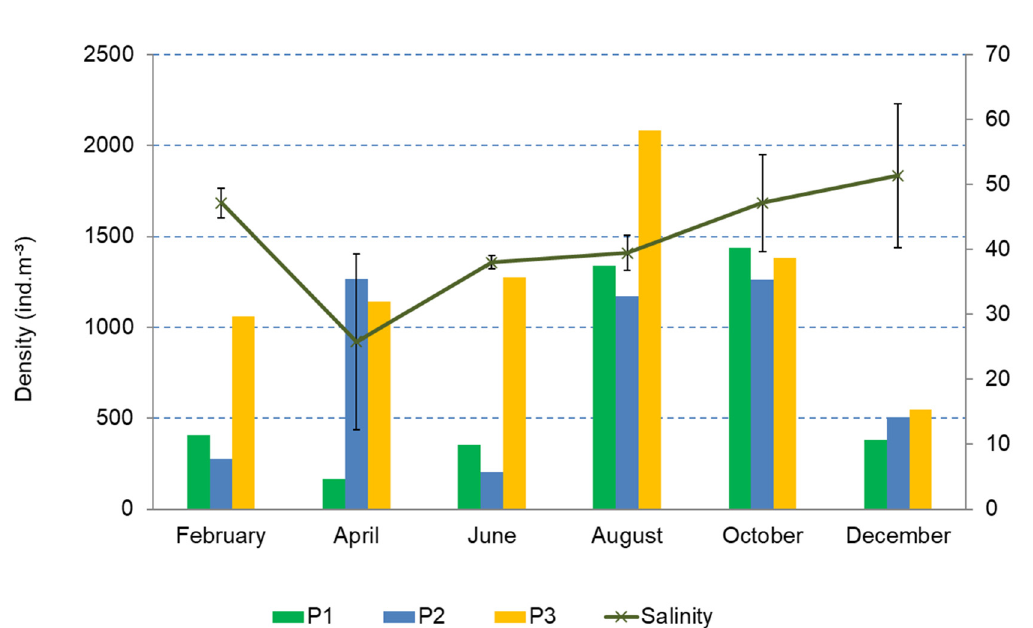
Figure 5. Copepod abundance (ind.m − 3 ) and salinity (mean with standard deviation) throughout the studied months in Piranji Estuary (equatorial Southwestern Atlantic, Brazil, year 2015). Point upstream of the river (P1) to the point closest to the estuarine mouth (P3).